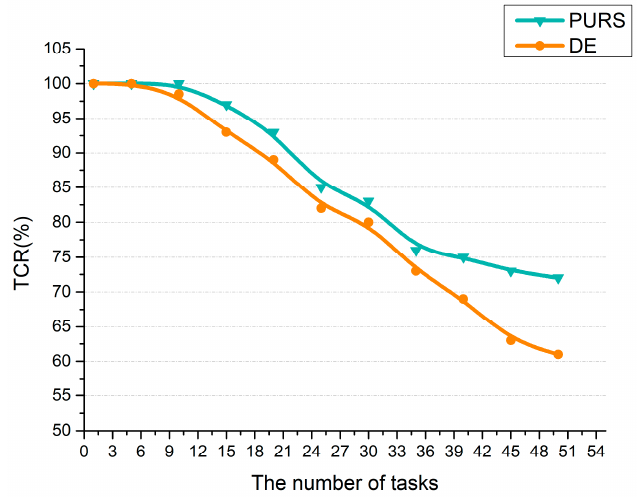
Figure 3. The task completion rate (TCR) of two algorithms.